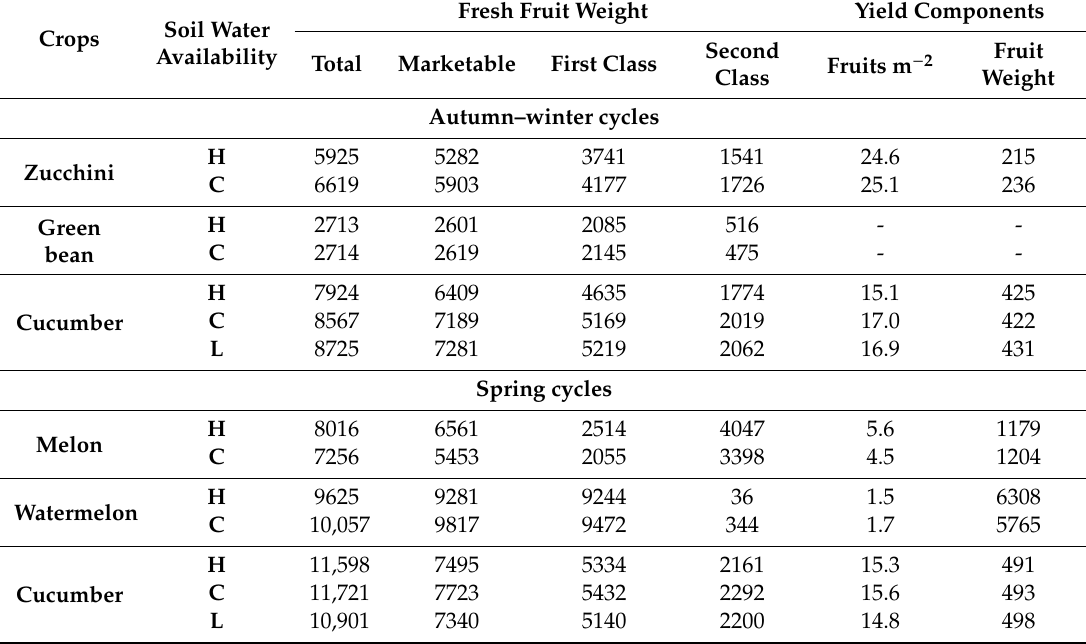
Table 6. Fresh weight of total, marketable, first and second class fruits (g m − 2 ), and yield components of marketable fruits: fruits number and mean fruit weight (g). Autumn–winter and spring cycles of greenhouse vegetable crops under high (H), conventional (C) and low (L) soil water availability